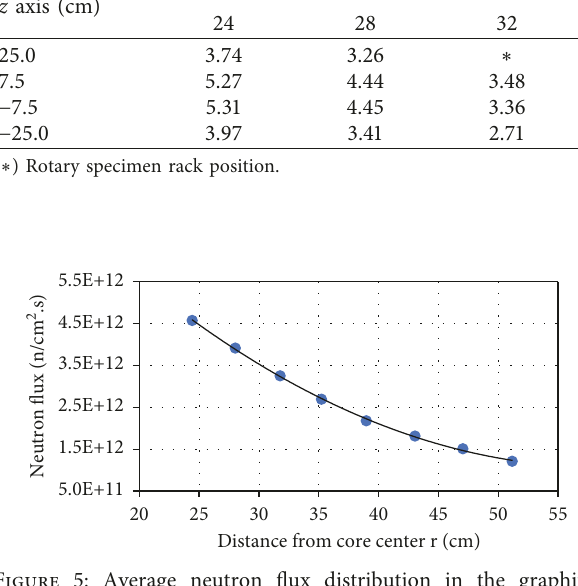
Table 4: Neutron flux distribution ( × 10 12 n/cm 2 .s) in the graphite reflector. z axis (cm)